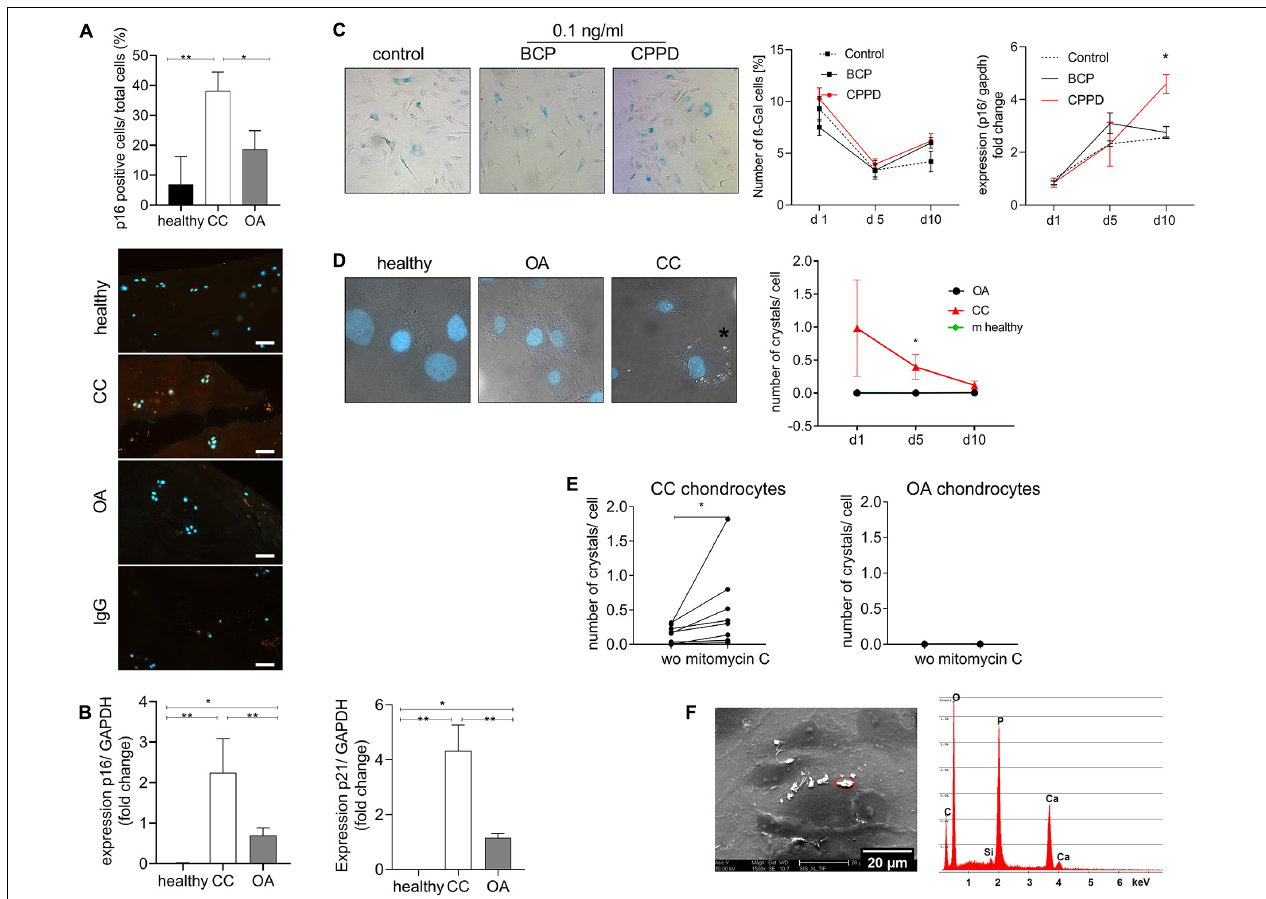
FIGURE 3 | Cellular senescence markers are increased in chondrocalcinosis (CC) cartilage. (A) Quantification of p16-stained cartilage area in healthy, CC, and osteoarthritis (OA) cartilage sections [one-way ANOVA: F (2,21) = 7.064, p = 0.0045]. Representative images of p16 staining, as well as IgG control staining, are shown (scale bar 50 µ m). (B) qRT-PCR for expression of senescence marker genes p16 (Kruskal–Wallis test: OA vs. CC: p = 0.038, CC vs. healthy: p = 0.0015, N = 5–15) and p21 (Kruskal–Wallis test: OA vs. CC: p = 0.05, CC vs. healthy: p < 0.0001, N = 5–15) of CC, OA, and healthy cartilage samples. (C) Stimulation of primary human chondrocytes with 0.1 ng/ml of basic calcium phosphate (BCP) or calcium pyrophosphate dihydrate (CPPD) crystals for up to 10 days and subsequent staining for β -Gal. Percentage of β -Gal-positive cells was counted [two-way ANOVA for time and treatment: F (4,30) = 1.65, p = 0.19]. Representative images for BCP and CPPD stimulation at day 10 are given p16 expression of chondrocytes treated with 0.1 ng/ml of BCP or CPPD crystals over the time course of 10 days [two-way ANOVA: F (4,15) = 3.94, p = 0.02]. (D) Culture of isolated chondrocytes from CC and OA cartilage, as well as murine neonatal chondrocytes, over a time course of 10 days. The number of crystals per cell was counted in DIC/DAPI-stained images. Representative images are given for healthy, CC, and OA chondrocytes at day 10 [two-way ANOVA: F (1,8) = 5.43, p = 0.04]. (E) Treatment of CC chondrocytes with mitomycin C to induce senescence. The number